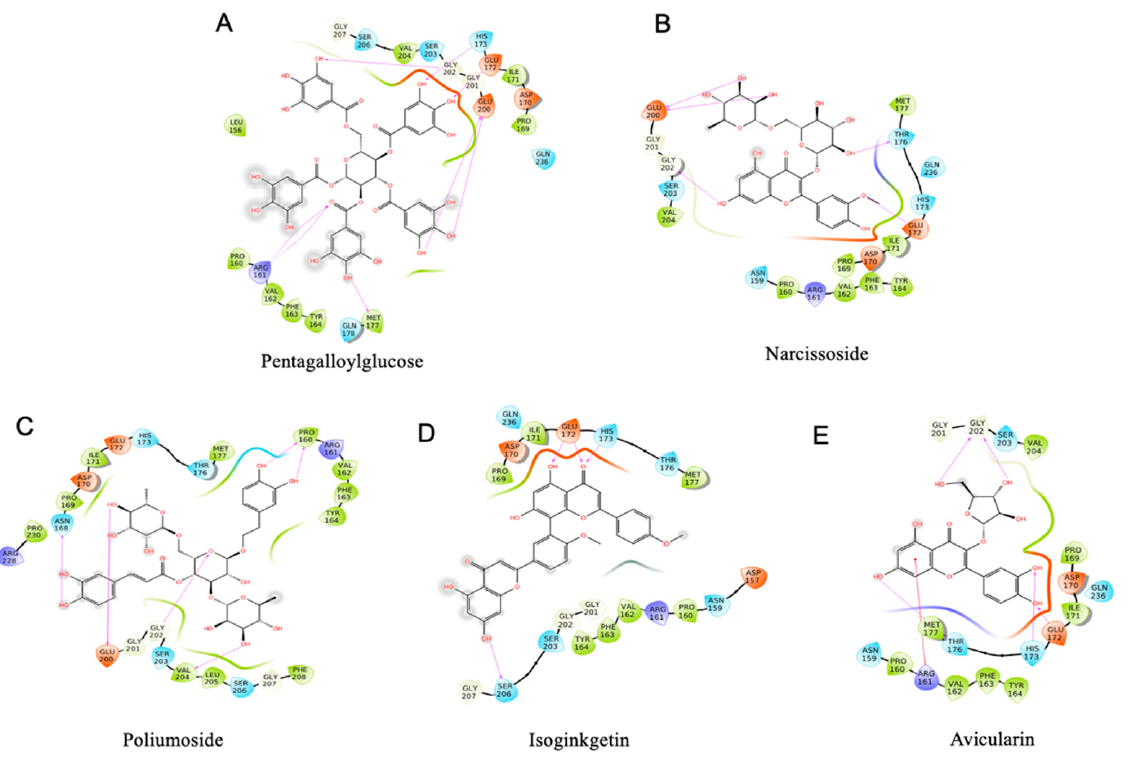
Figure 2. Molecular interaction diagram of top-ranking phytochemical binding with soybean 11S globulin. ( A ) Pentagalloylglucose, ( B ) narcissoside, ( C ) poliumoside, ( D ) isoginkgetin, ( E ) avicu- larin. Table 1. Top 20 phytochemical compounds from virtual screening.